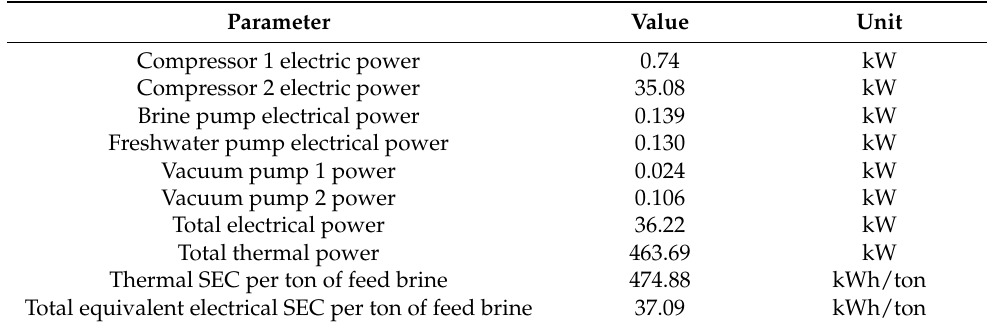
Table 14. Energy consumption results from the conventional ZLD system for 1,000 kg/h of feed brine.